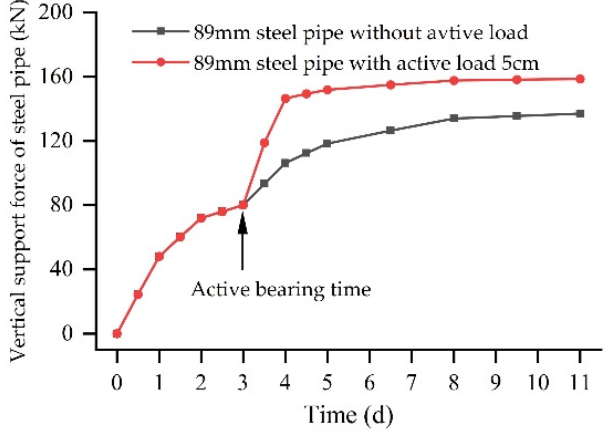
Figure 17. Effect comparison of 89 × 8 mm steel pipe preloading displacement of 50 mm.